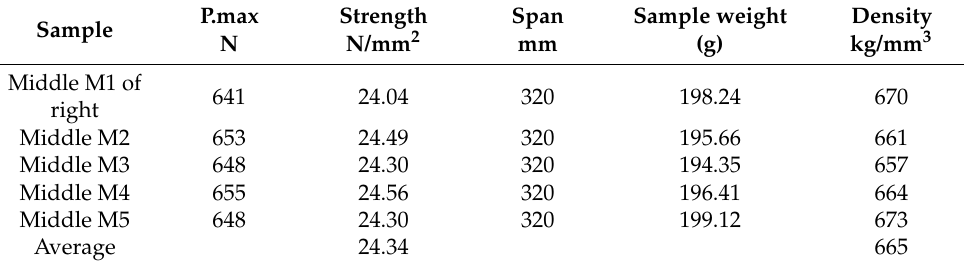
Figure 8. X-ray vertical density profile of 1st specimen. Table 5. Bending tests. Table 7. Experimental data of 1st sample.